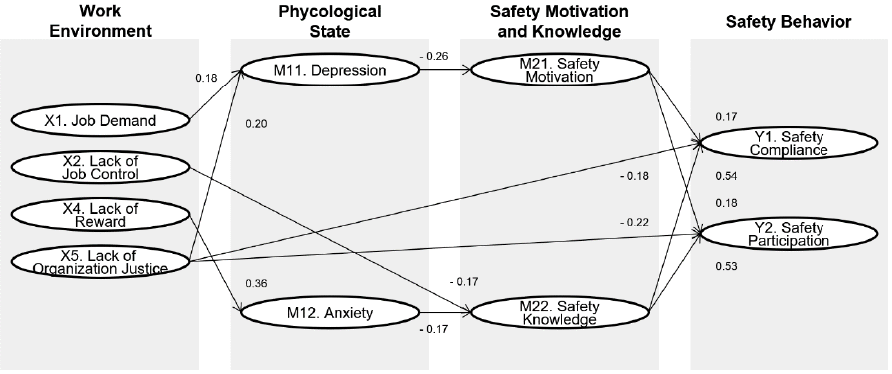
Figure 2. The final model.